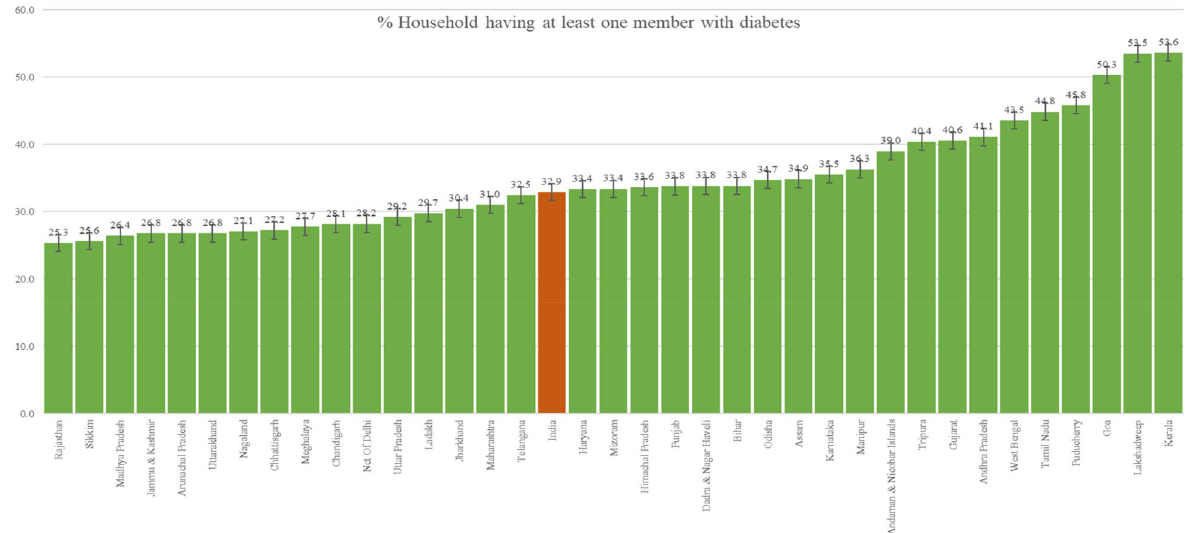
Figure 2. Proportion of households with at least one diabetic member across states of India, 2019–2021 (see Supplementary Table